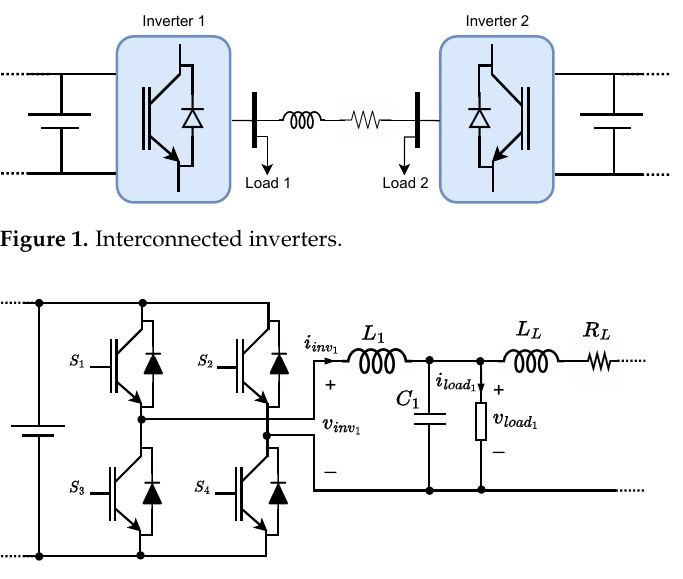
Figure 2. The circuit of a VSC with an LC filter connected to the load and interconnection line.